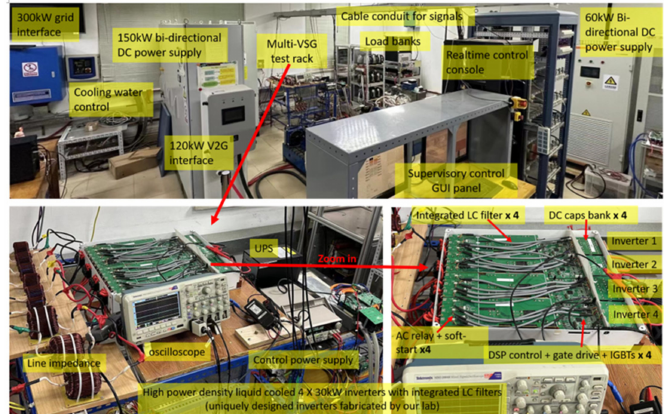
Figure 16. Experimental